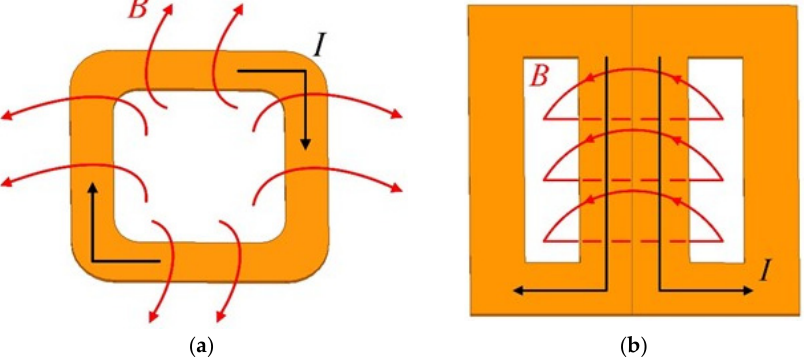
Figure 4. The magnetic field distribution diagram of the coils: ( a ) unipolar coil topology; ( b ) bipolar coil